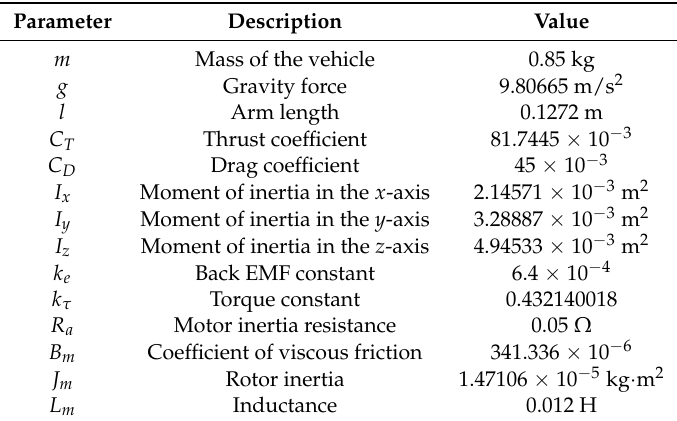
Table 1. Multirotor